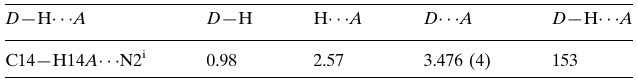
Hydrogen-bond geometry (A˚ , (cid:1)